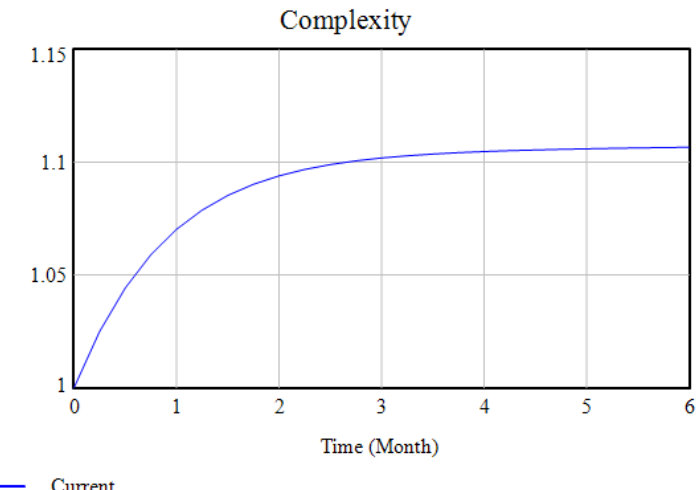
Figure 14. Simulation result of ‘Complexity’.